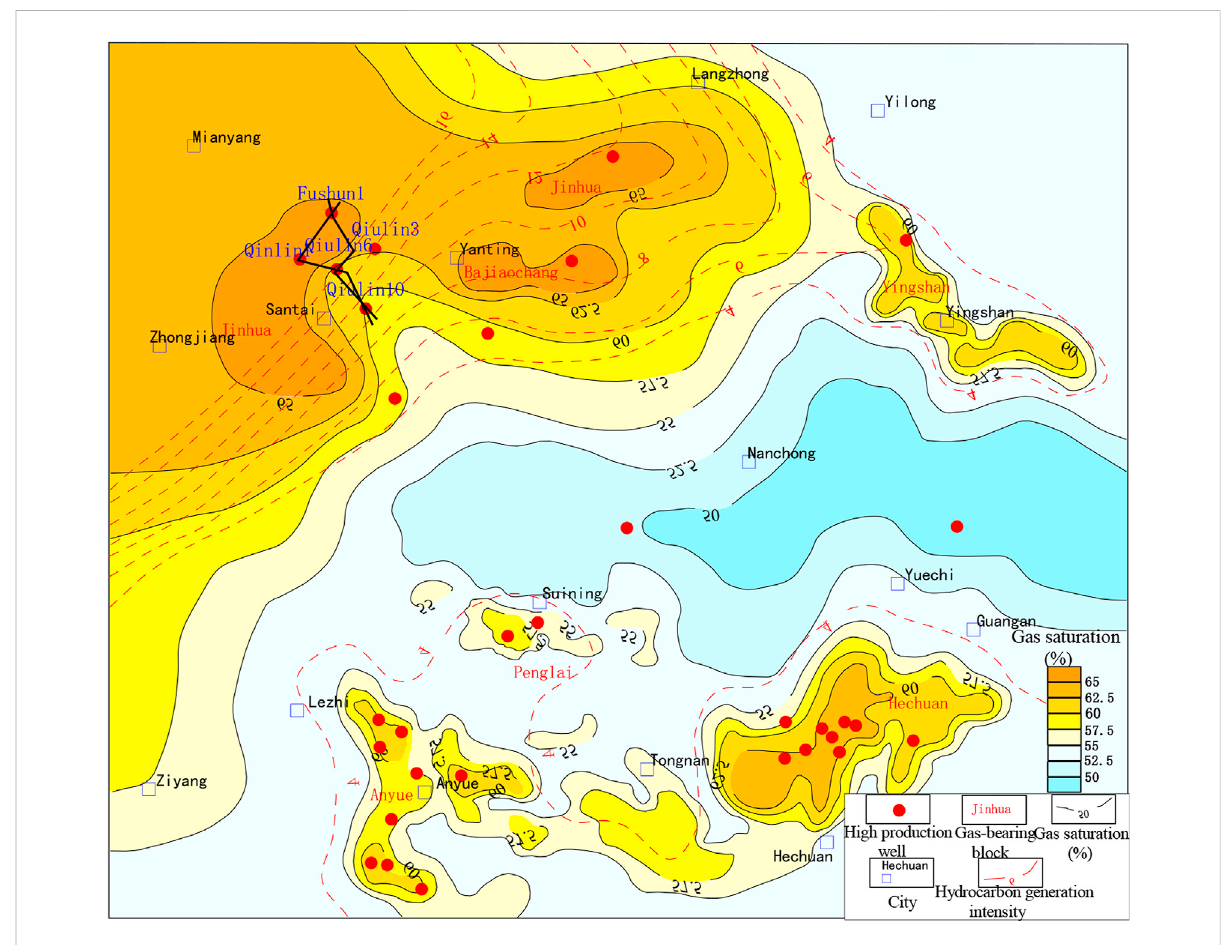
FIGURE 8 Coupling relationship betweenthegassaturation oftheXu2Memberandthehydrocarbongenerationintensityoftheunderlying Xu 1Member in the central and western Sichuan